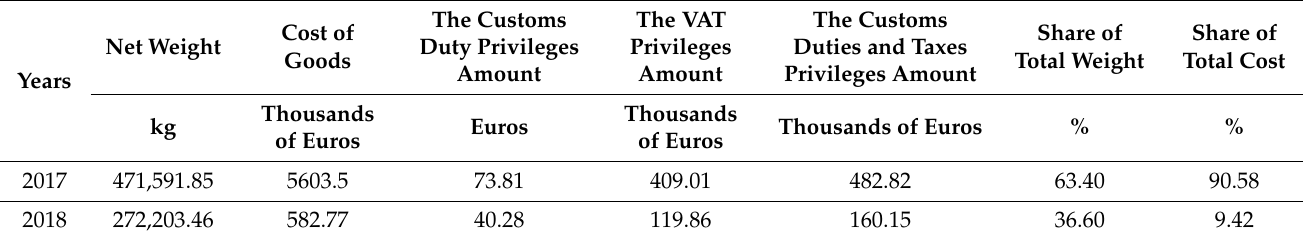
Table 3. Data on the cost of goods imported into the territory of the free port of Vladivostok and privileges from 2017–2018 *. The VAT The Customs Cost of Duty Privileges Net Weight Goods Amount Years